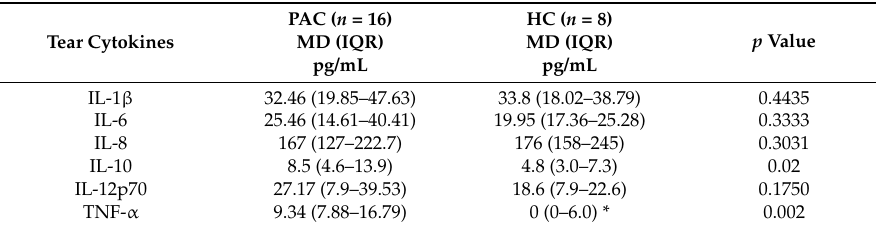
Table 3. Tear cytokines in patients with perennial allergic conjunctivitis (PAC) and healthy controls (HC).